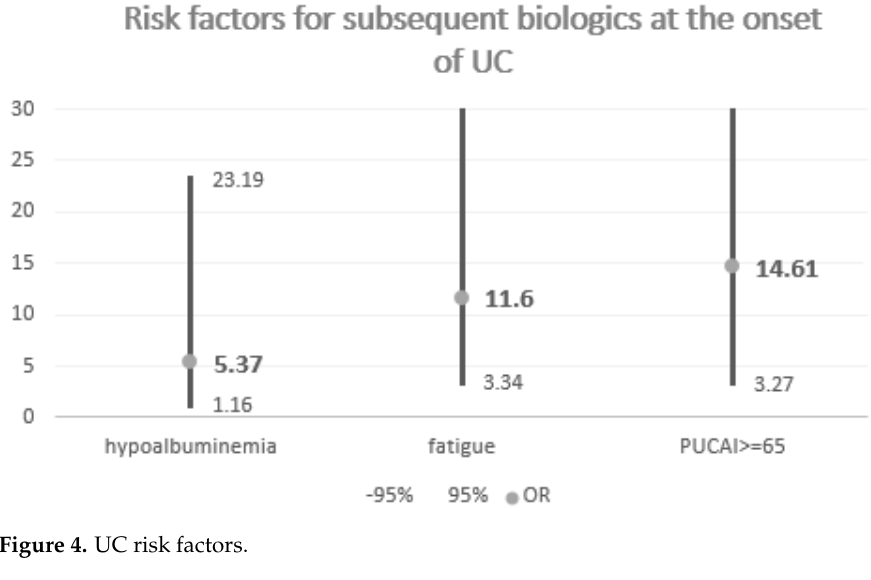
Figure 4. UC risk factors.